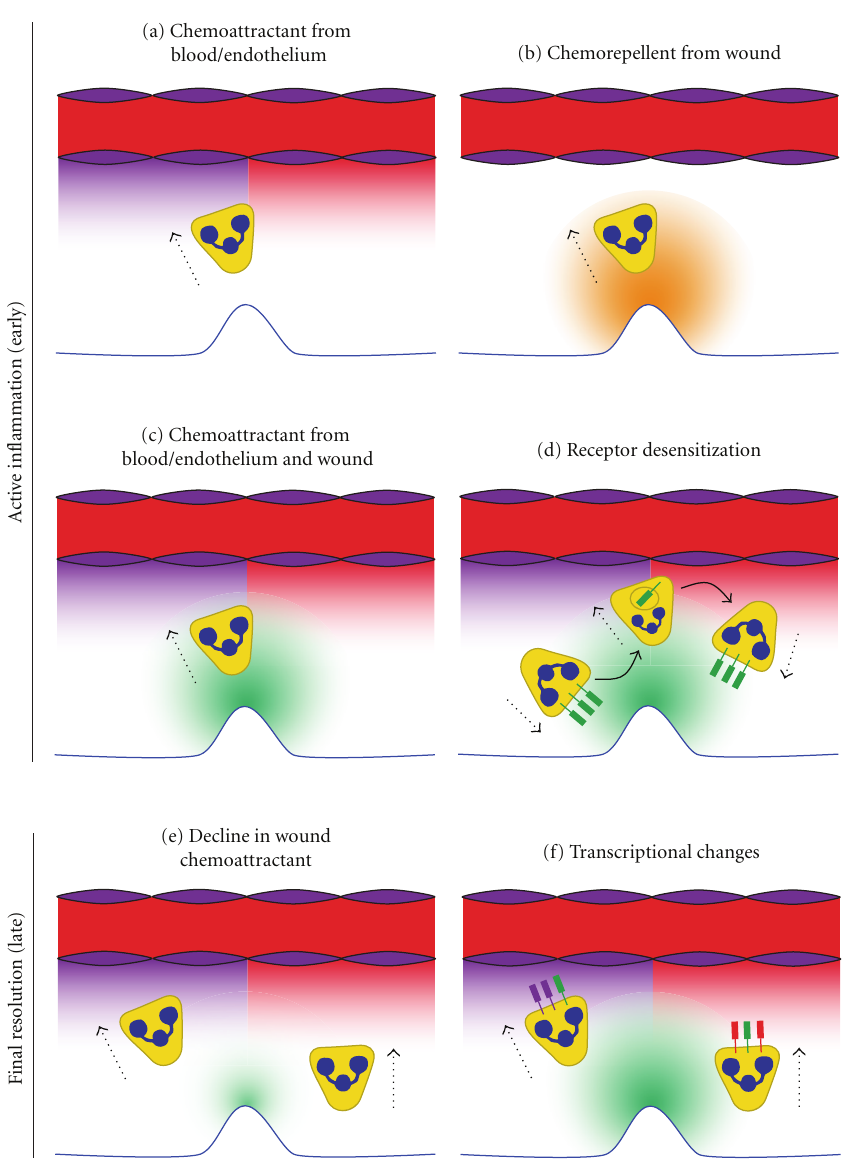
Figure 2: Proposed mechanisms for reversed migration. This diagram illustrates how chemoattractant gradients from the blood (red), endothelium (purple), and wound (green) or chemorepellent gradients (orange) may influence reverse migration. The color of a chemoattractant receptor matches the gradient to which it responds. (a)–(d) Reverse migration in the early wound response. (a) Demonstration of neutrophil reverse migration towards blood or endothelium-derived chemoattractants. (b) Reverse migration of a neutrophil away from a wound-derived chemorepellent. There could be competition between wound-derived chemoattractants (not shown) and chemorepellents promoting reverse migration, or neutrophils may perform fugetaxis from areas of high chemoattractant concentration. (c) Oscillatory behavior of neutrophils suggests competing gradients of chemoattractants may exist between the wound and vasculature. (d) Receptor desensitization, via internalization or other mechanisms, may allow neutrophils to oscillate between the wound and the vasculature while others are still actively responding to the wound. (e)–(f) Mechanisms that promote resolution of neutrophil-mediated inflammation at wounds. (e) During the healing phase, wounded tissue may gradually produce less neutrophil chemoattractant, shifting the balance to favor reverse migration. (f) Neutrophils that responded to a wound may initiate transcriptional changes favoring reverse migration from the wound. Potential changes include altered expression or sensitivity of chemoattractant